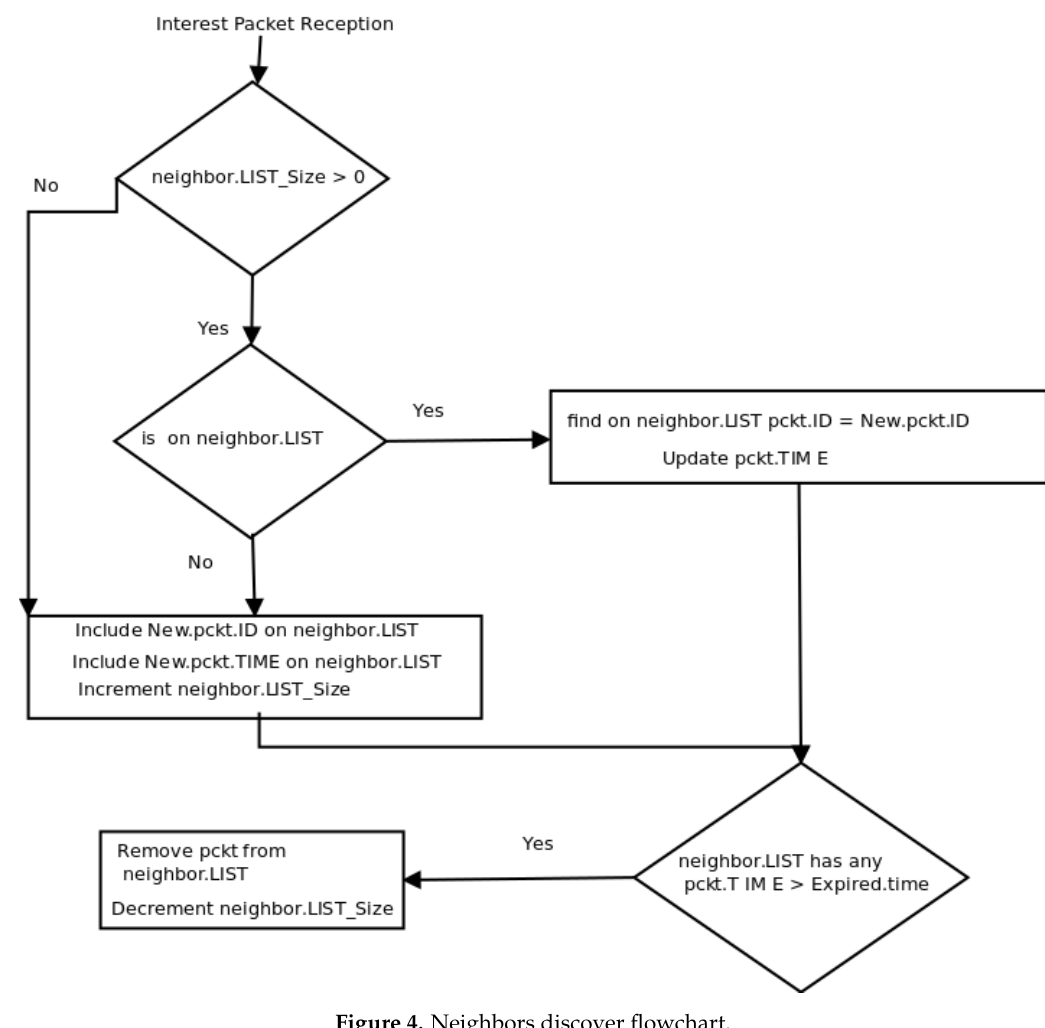
Figure 4. Neighbors discover